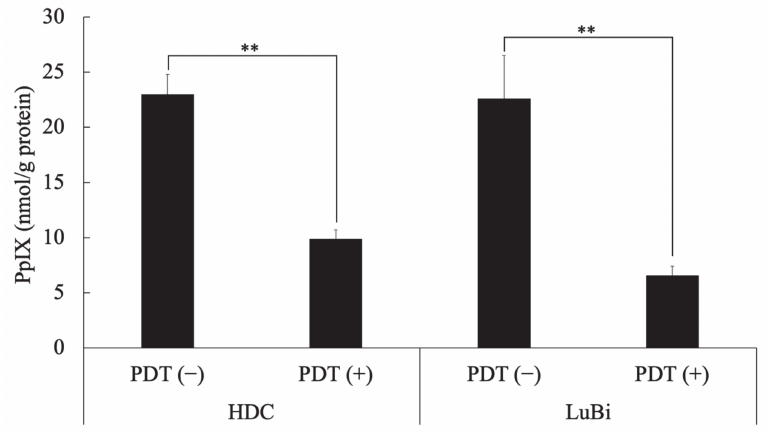
Figure 1. Intracellular PpIX concentration in canine primary lung adenocarcinoma cell lines. HDC and LuBi cells were seeded at 1 × 10 6 into a 75 cm 2 tissue culture flask and incubated overnight. The HDC and LuBi cells were then incubated with 1 mM 5-ALA for 4 h (PDT ( − )). After changing the medium, the cells were irradiated with an LED light source light (630 nm, 20 mW/cm 2 , 10 J/cm 2 ) (PDT (+)). Intracellular PpIX concentrations in the HDC and LuBi cells were analyzed with high- performance liquid chromatography. Results are presented as mean ± standard deviation ( n = 3). Groups were compared using Sidak’s multiple comparison test, ** p < 0.01.